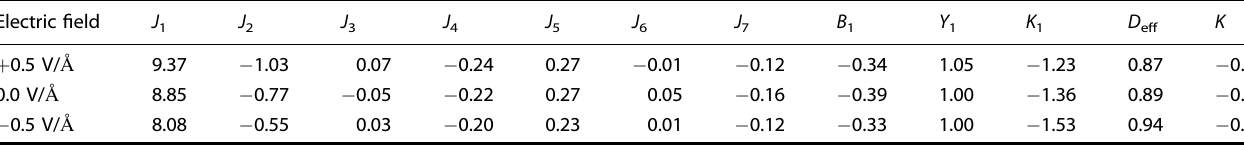
Table 1. Variation of interaction constants with electric fi